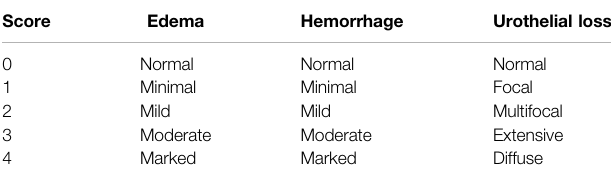
TABLE 1 | Grading scheme used for bladder tissue histological